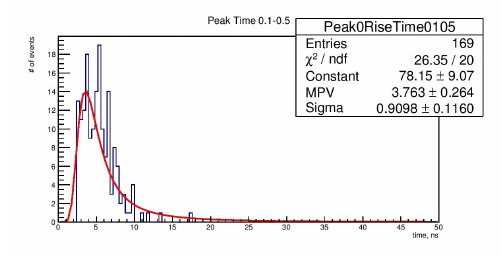
Figure 3. Rise time from 0.1 to 0.5 of pulse area